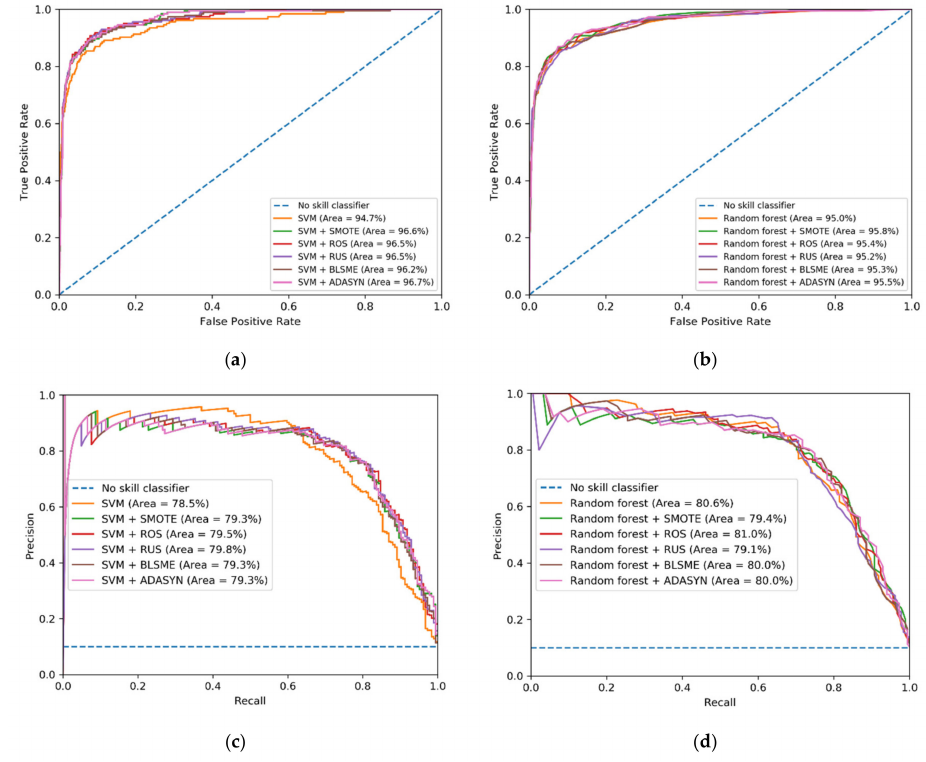
Figure A7. The ROC and PR curves of SVM and Random Forest for Fold 6; ( a ) the ROC curve of SVM; ( b ) the ROC curve of Random Forest; ( c ) the PR curve of SVM; and, ( d ) the PR curve of Random